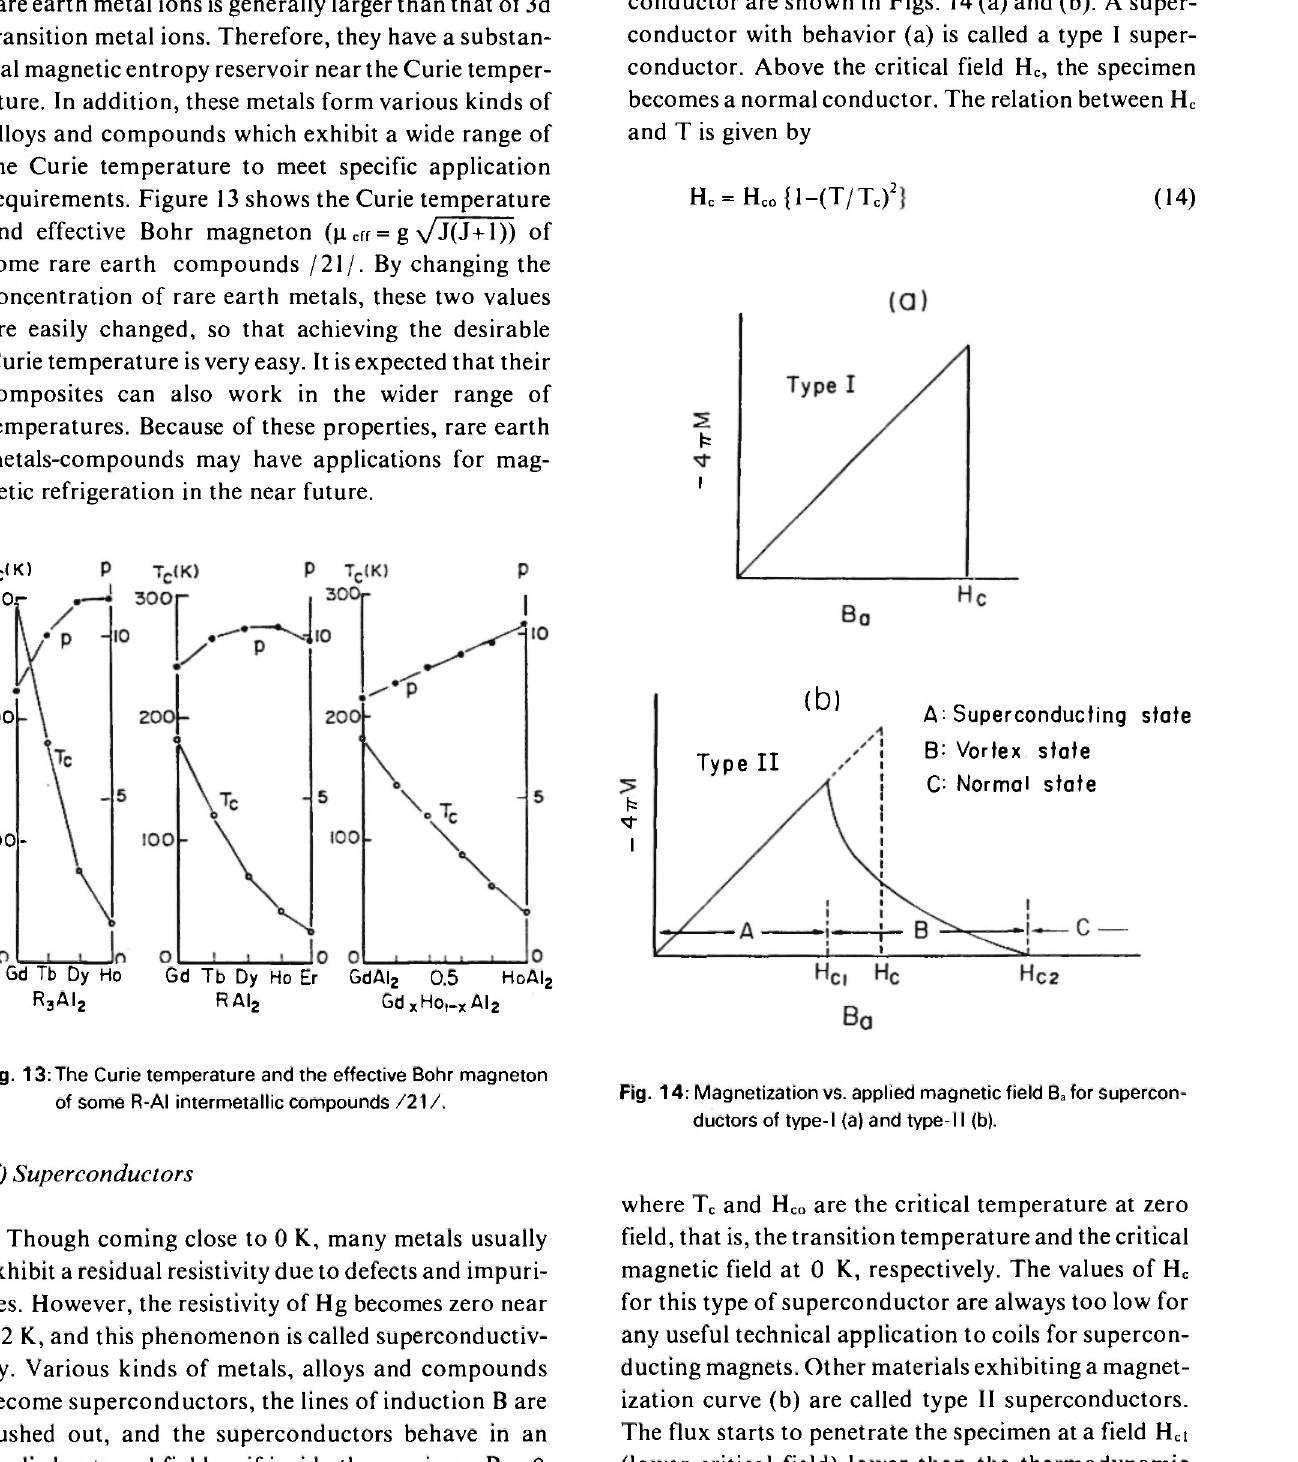
Fig. 13: The Curie temperature and the effective Bohr magneton of some R-AI intermetallic compounds /21/. Fig. 14: Magnetization vs. applied magnetic field B a for supercon- ductors of type-I (a) and type-II